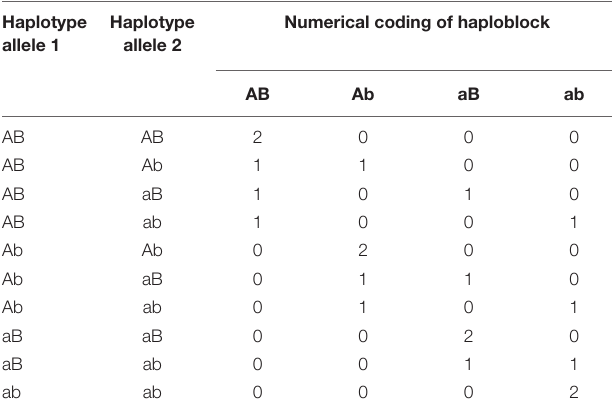
TABLE 1 | Numerical dosage coding of a haploblock formed by two consecutive single nucleotide polymorphisms